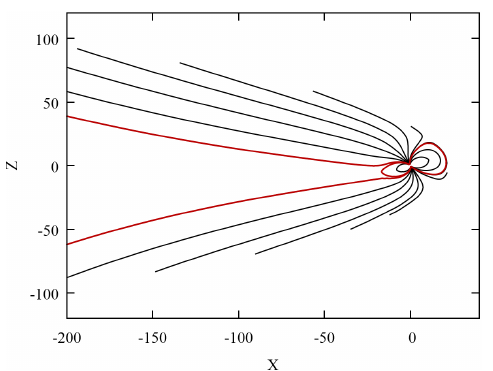
Figure 7. Example of the 2-D structure of Saturn’s magnetosphere for northward IMF in case 9 (see Table 1). Separatrices are shown in